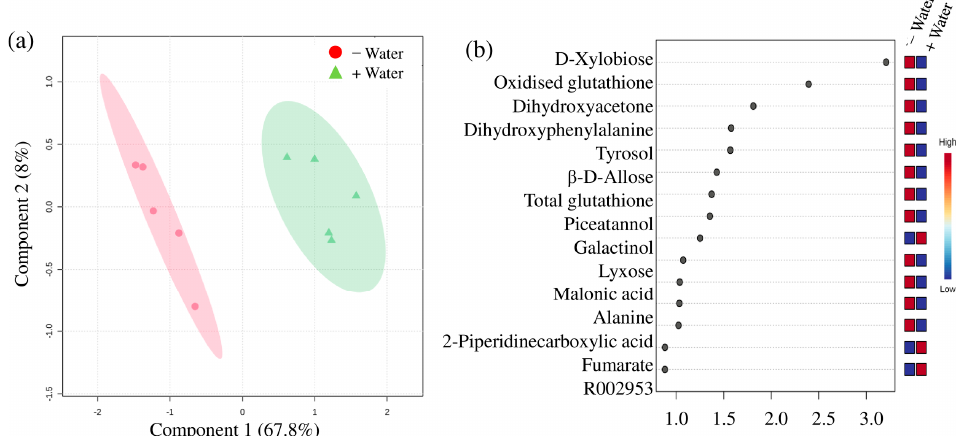
Figure 9. Clustering ( a ) of Alnus glutinosa grown under sufficient (+ water, triangle) and limited ( − water, circle) water conditions. PLS-DA analysis was performed based on 46 with significant differences. Semi-transparent shadings indicate 95% confidence regions. ( b ) The most important 15 parameters according to VIP (Variable Importance for Projection) scores generated from PLS-DA analysis.